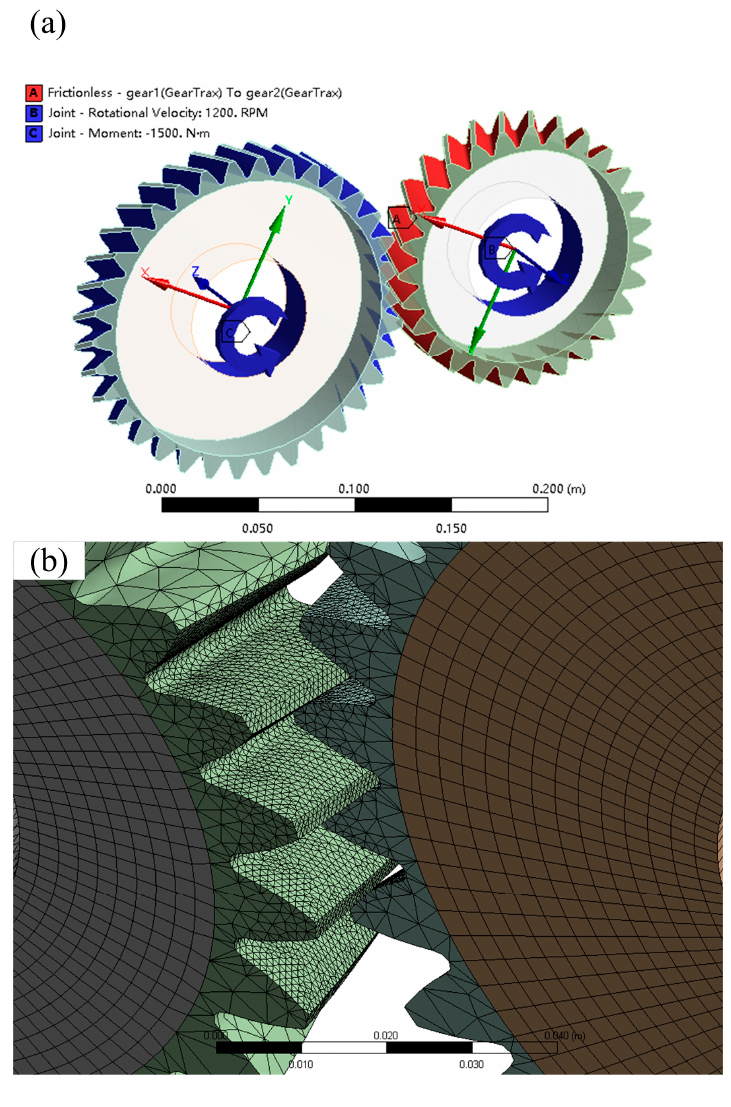
Figure 4. Finite element method (FEM) model: ( a ) constraints and loadings and ( b ) mesh.